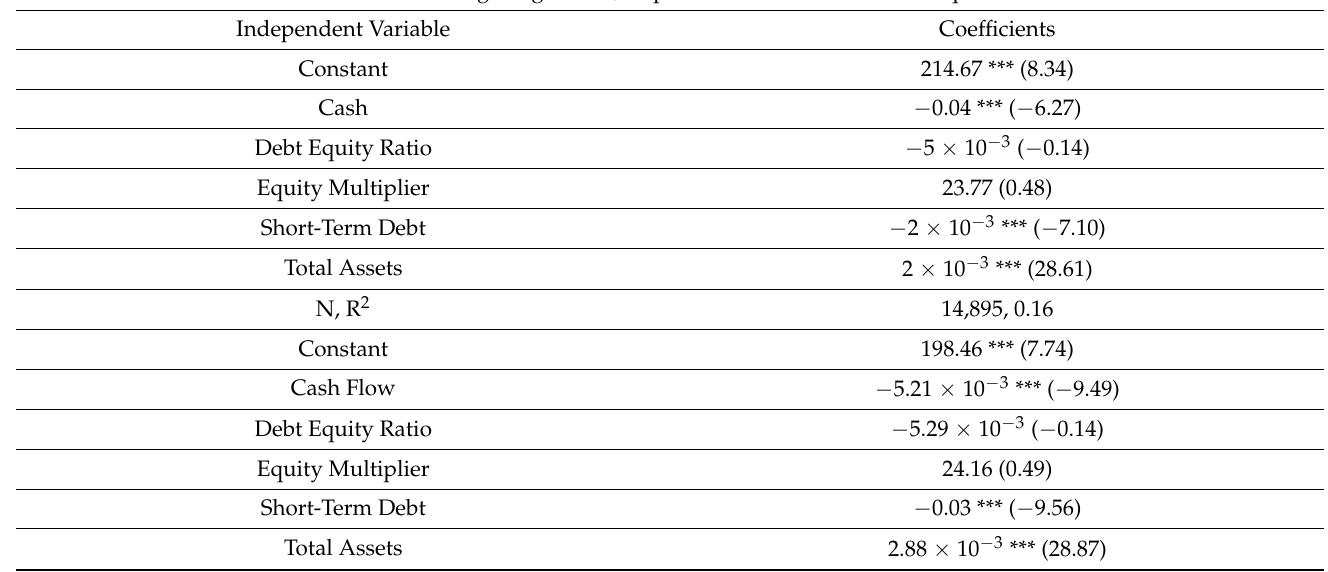
Table 9. Two-Stage Least Squares Regressions of Acquisition Size on Cash Holdings, Cash Flow, Cash from Debt, and Cash from Equity (First-Stage Regression) and Returns, Return on Assets (ROA)